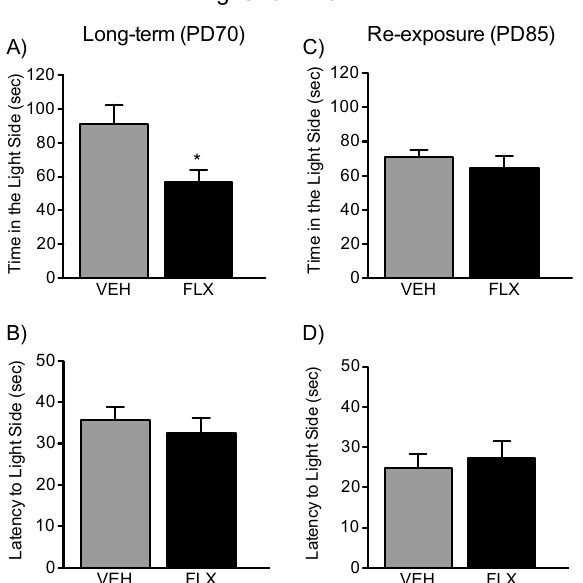
Figure 3. Long-term effects of juvenile fluoxetine (FLX) treatment, and its re-exposure in adulthood, on the light/dark box. ( A ) Juvenile FLX pretreatment (PD35-49) led to a significantly decreased time spent in the lighted-side of the light/dark box at PD70 (Long-Term), when compared to water (VEH)-pretreated controls. ( B ) When compared to VEH-pretreated controls, juvenile FLX pretreatment did not influence the time it took the animals to first enter the lighted-side of the apparatus. ( C ) FLX re-exposure in adulthood (PD70-84) ameliorated the long-lasting anxiety-like effect of juvenile FLX pretreatment, as no differences in total time spent in the center between the groups were observed. ( D ) At PD85, no differences in the time it took for animals to first enter the lighted-side of the apparatus were apparent between the experimental groups. Data are presented as mean ± SEM. * p <